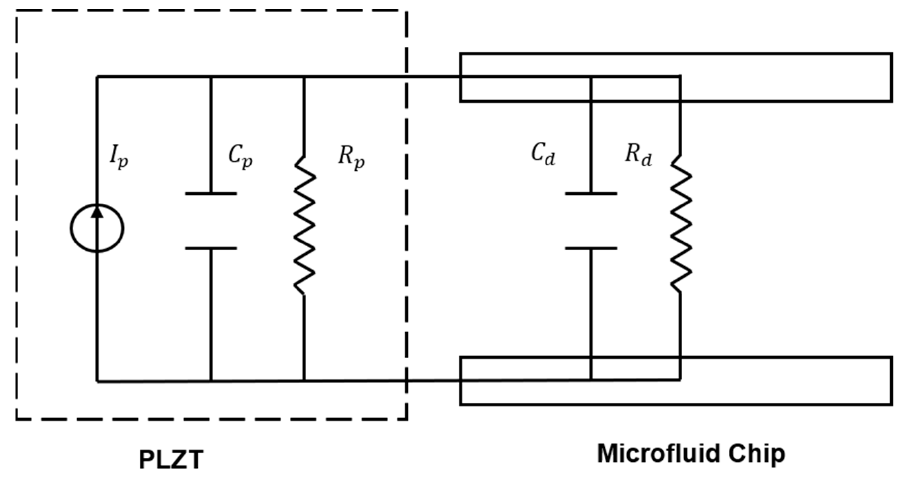
Figure 3. Equivalent circuit model for the LCVDS.